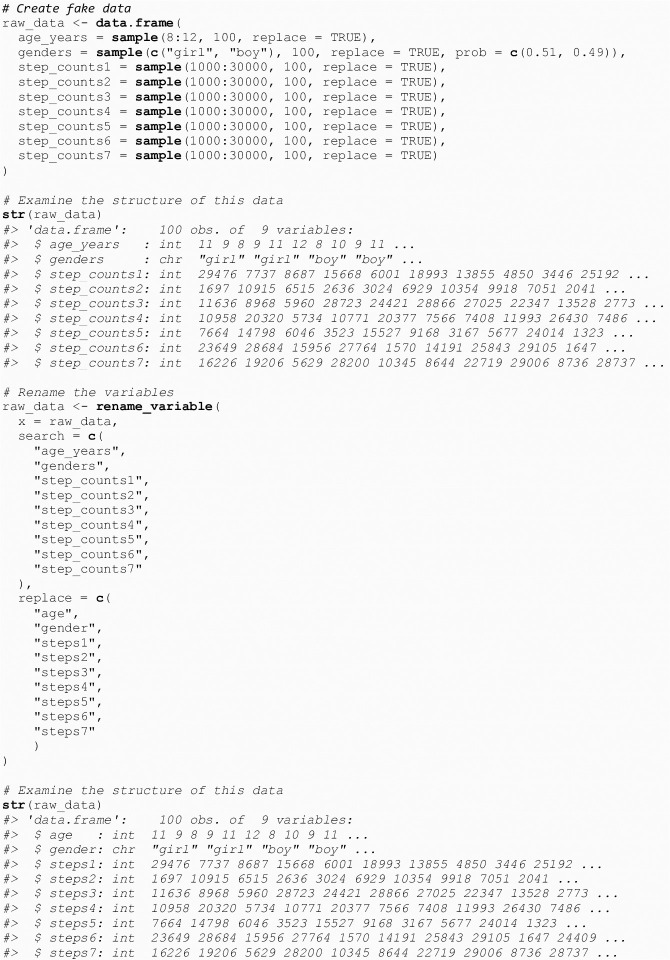
Rename variables.